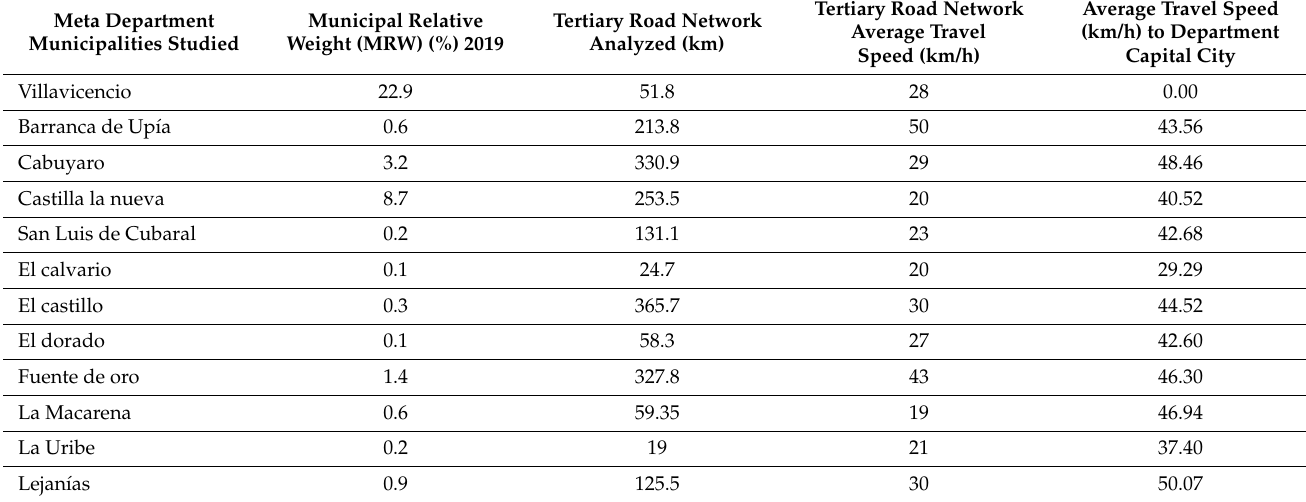
Table A3. Meta department municipalities studied information: MRW, tertiary road network length, and average travel